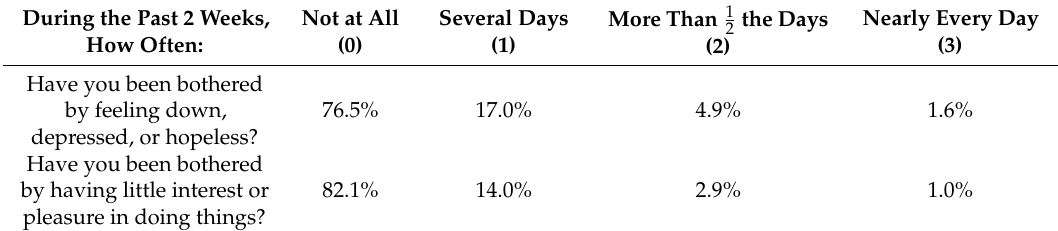
Table 1. Percent maternal depression screening items ( N = 693) a,b .